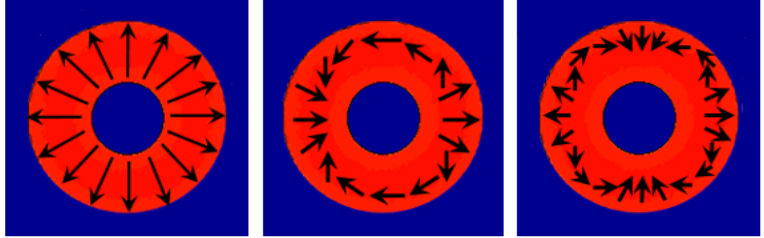
Figure 1. Schematic presentation of the cross-section of the cylindrical vector laser beams (CVB) with different polarization distribution, defined by l and σ . Here, left : l = + 1, σ = − 1, middle : l = + 2, σ = − 1 and right : l = + 3, σ = − 1,